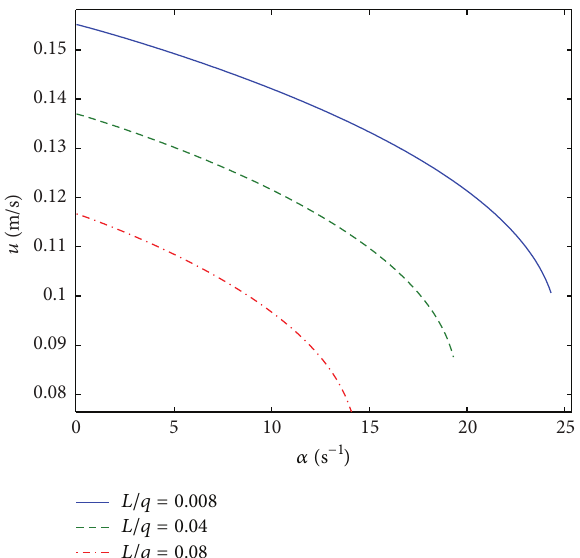
Figure 5: Influence of latent heat of vaporization on spray flame propagation velocity—evaporation front case.